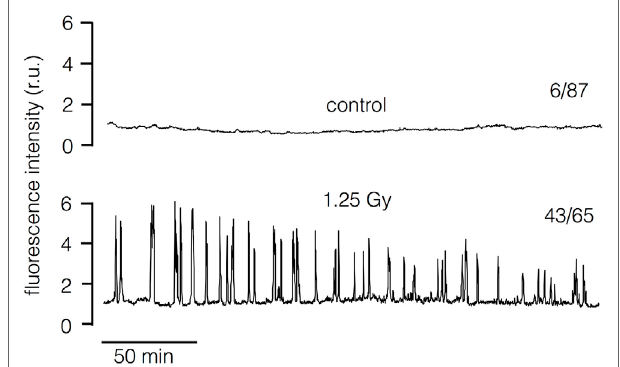
FigUre 3 | Ionizing irradiation stimulates oscillations of cytosolic Ca 2 + in Jurkat cells. Representative recordings of Fluo-4 fluorescence in untreated control cell (top) and in cell after exposure to 1.25 Gy x-Ray (bottom). The recordings start approximately 7 min after exposure to radiation. The numbers of cells ( n ) which show [Ca 2 + ] cyt oscillations 1 h after irradiation (1.25 Gy) or after sham treatment (control) with respect to total number of cells investigated ( N ) is reported at respective traces ( n / N ). Data are pooled from three independent experiments.